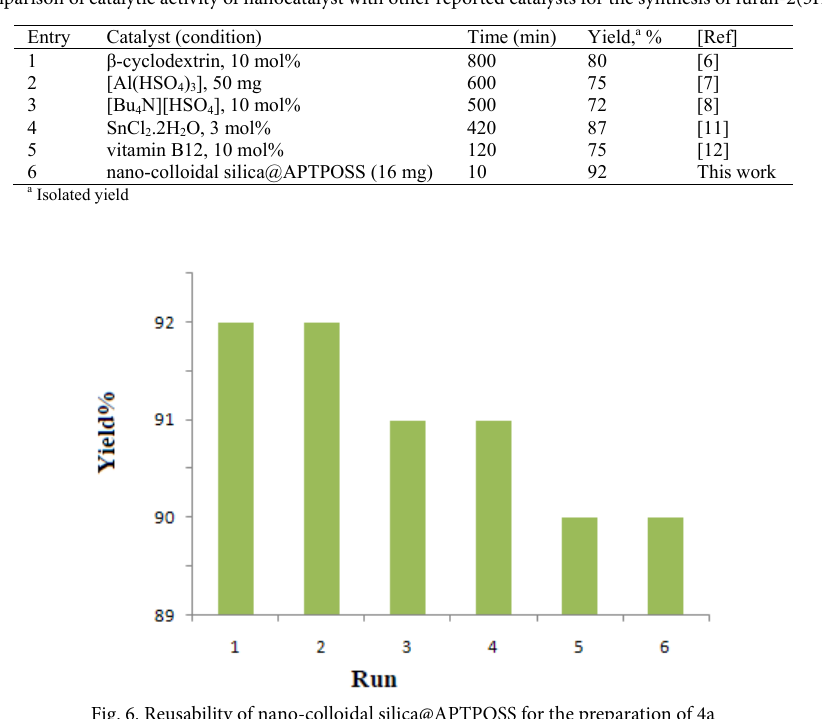
Fig. 6 . Reusability of nano-colloidal silica@APTPOSS for the preparation of 4a